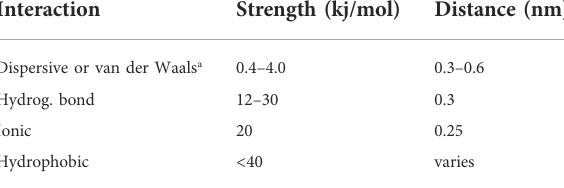
TABLE 1 Cohesive supramolecular energies.